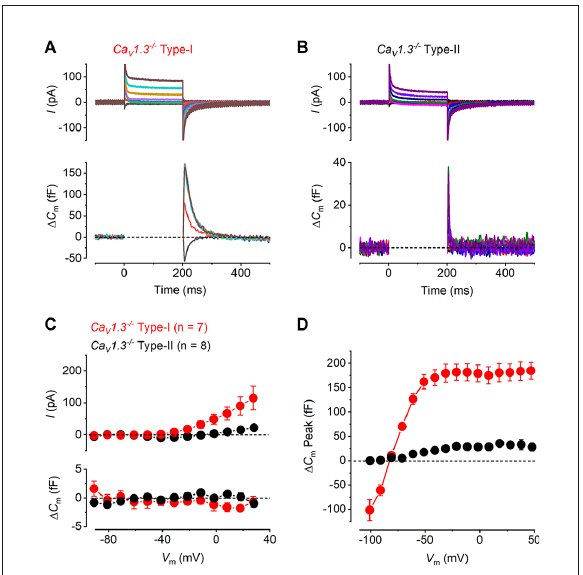
FIGURE3 Ca 2+ currents and Ca 2+ dependent exocytosis in hair cells of mature Ca V 1.3 − / − mouse utricles. (A,B) Representative I Ca (upper panels) and the corresponding ∆ C m (lower panels) from a type-I and a type-II hair cells from Ca V 1.3 − / − mice, respectively, in response to the same voltage protocols used in Figures 2A,B . I Ca and sustained ∆ C m responses were completely abolished in both hair cell types from Ca V 1.3 − / − mice, while the transient ∆ C m responses were still present. (C) Mean peak I-V relations (upper panel) and the corresponding mean sustained ∆ C m - V relation (lower panel) for type-I (red, n = 7) and type-II (black, n = 8) hair cells from Ca V 1.3 − / − mice. (D) Mean transient ∆ C m peak amplitude in type-I ( n = 7) and type-II ( n = 8) hair cells from Ca V 1.3 − / −